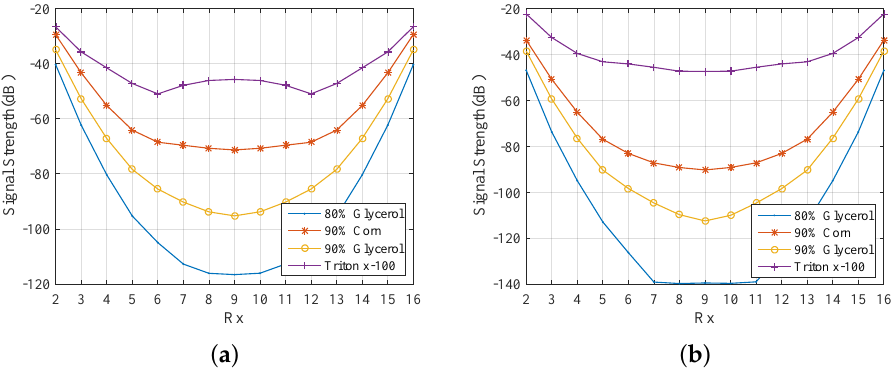
Figure 5. CST-calculated received signal strength as a function of receiver number for a 150 mm diameter array immersed in 80% glycerine, 90% corn syrup, 90% glycerine, and Triton X-100, when Transmitter 1 transmits ( a ) at 1.5 GHz and ( b ) 2